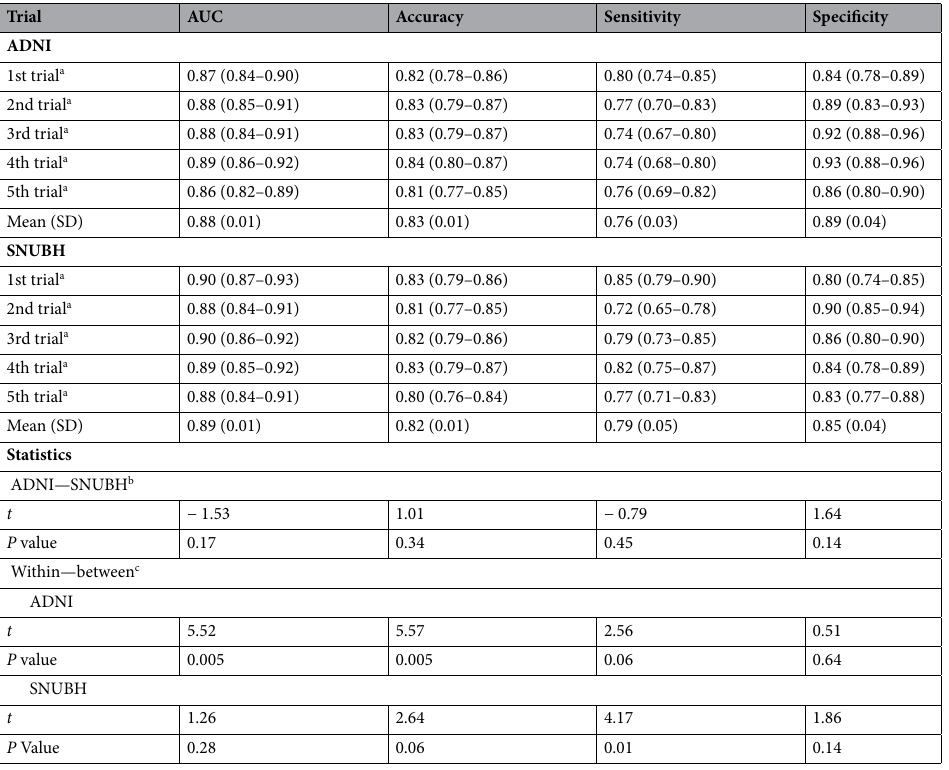
Table 2. Between-dataset testing of AD classification algorithms. AD classification algorithms were developed by randomly selecting 80% of the participants (156 AD patients and 156 CN controls) in each dataset (ADNI and SNUBH) and tested within each dataset on the remaining 20% of the participants (39 AD patients and 39 CN controls). AUC area under the receiver operating characteristic curve, ADNI dataset from the Alzheimer’s Disease Neuroimaging Initiative, SNUBH dataset from the Seoul National University Bundang Hospital, SD standard deviation. a 95% confidence intervals in parentheses. b Comparison of performances on the ADNI and SNUBH datasets using Student’s t-test. c Comparison of within-dataset and between-dataset performances using a paired